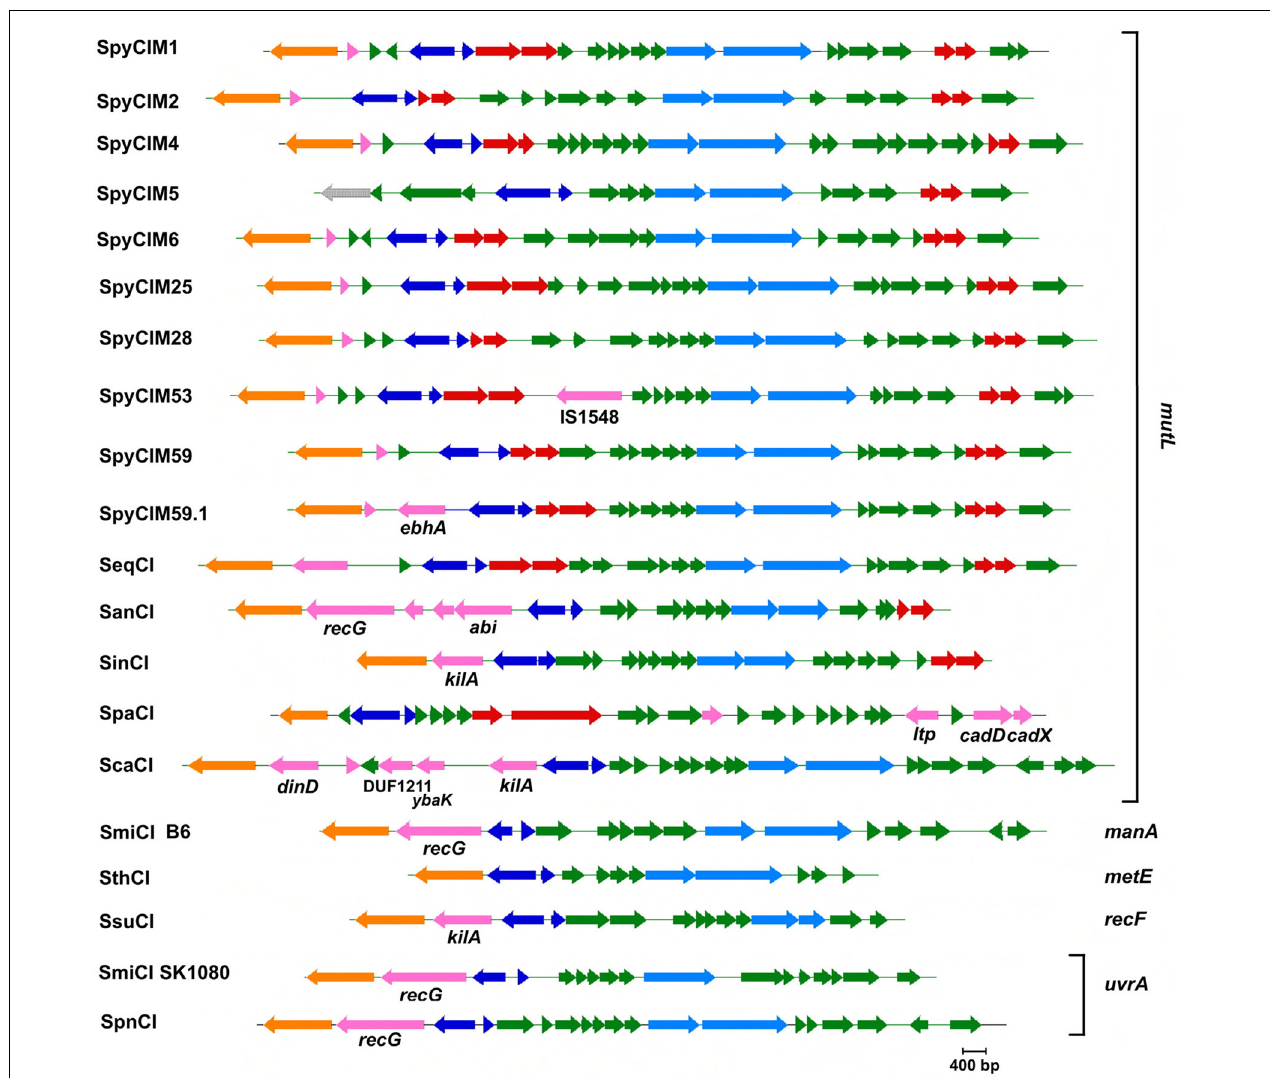
FIGURE 6 | The CI of S. pyogenes and related species. The identification of each CI is shown to the left of its map, while the integration site ( attB ) is shown to the right of the map (see Tables 1, 2 for identification of CI and attB sites). INDELs with identifiable homologous genes are labeled by that homolog. Color key: orange—site-specific integrase; dark blue—control of lysogeny; light blue—DNA replication; red—maintenance; pink—INDELs; green—unknown function; gray—pseudogene. INDEL key: